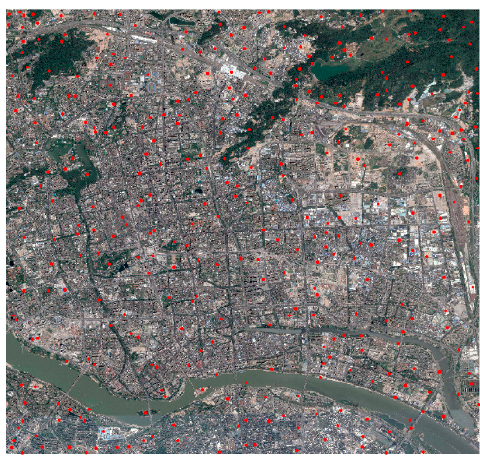
Figure 6. The distribution of the 360 validation samples in study area. Validation samples are indicated in red and comprised 200 ISA samples, 100 vegetation samples, and 60 soil samples.